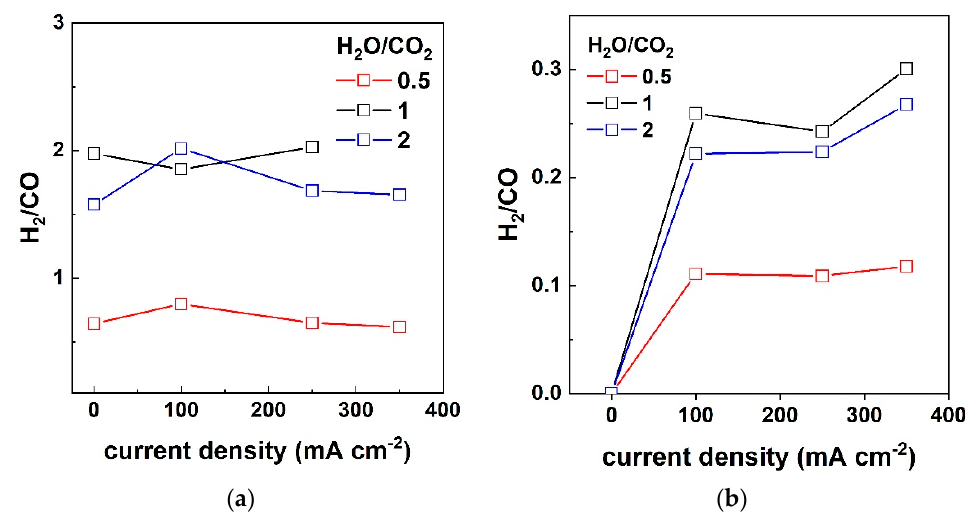
Figure 9. The ratio of H 2 /CO, as calculated from the outlet analysis, under open circuit and electrolysis conditions (100–350 mA cm − 2 ) for three S/C ratios: 0.5, 1 and 2 when H 2 is ( a ) present and ( b ) absent from the feed, at 900 °C.